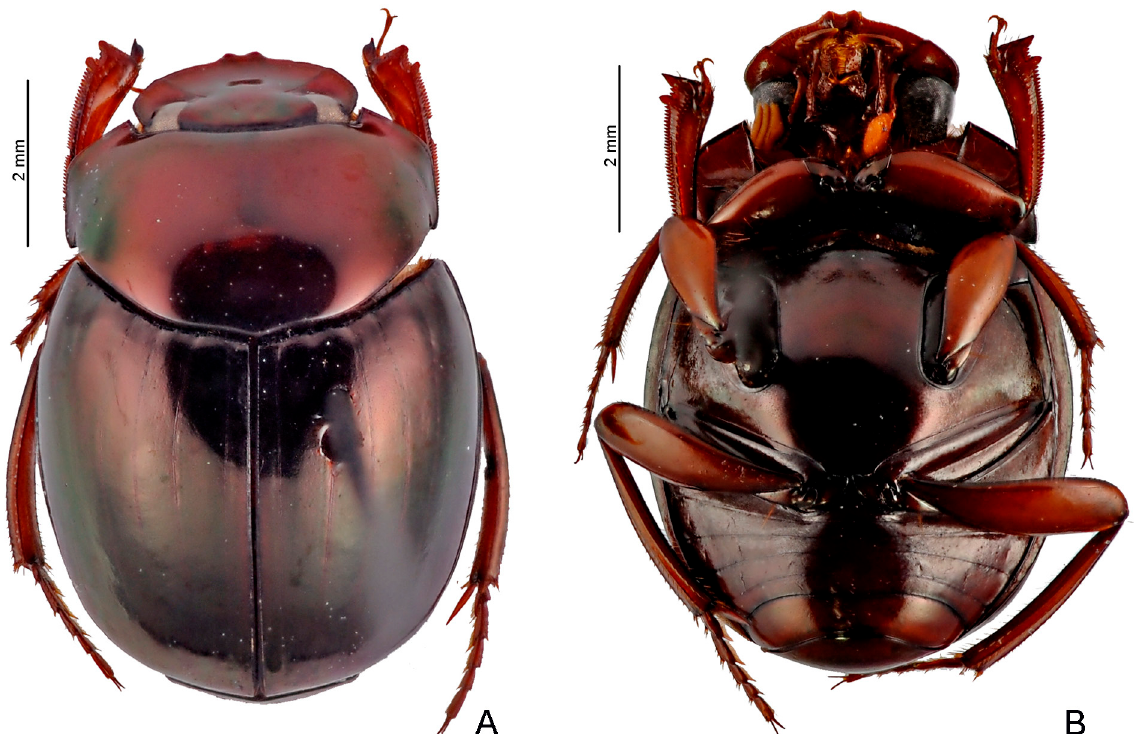
Fig. 27. Sylvicanthon genieri sp. nov. A . Dorsal view. B . Ventral